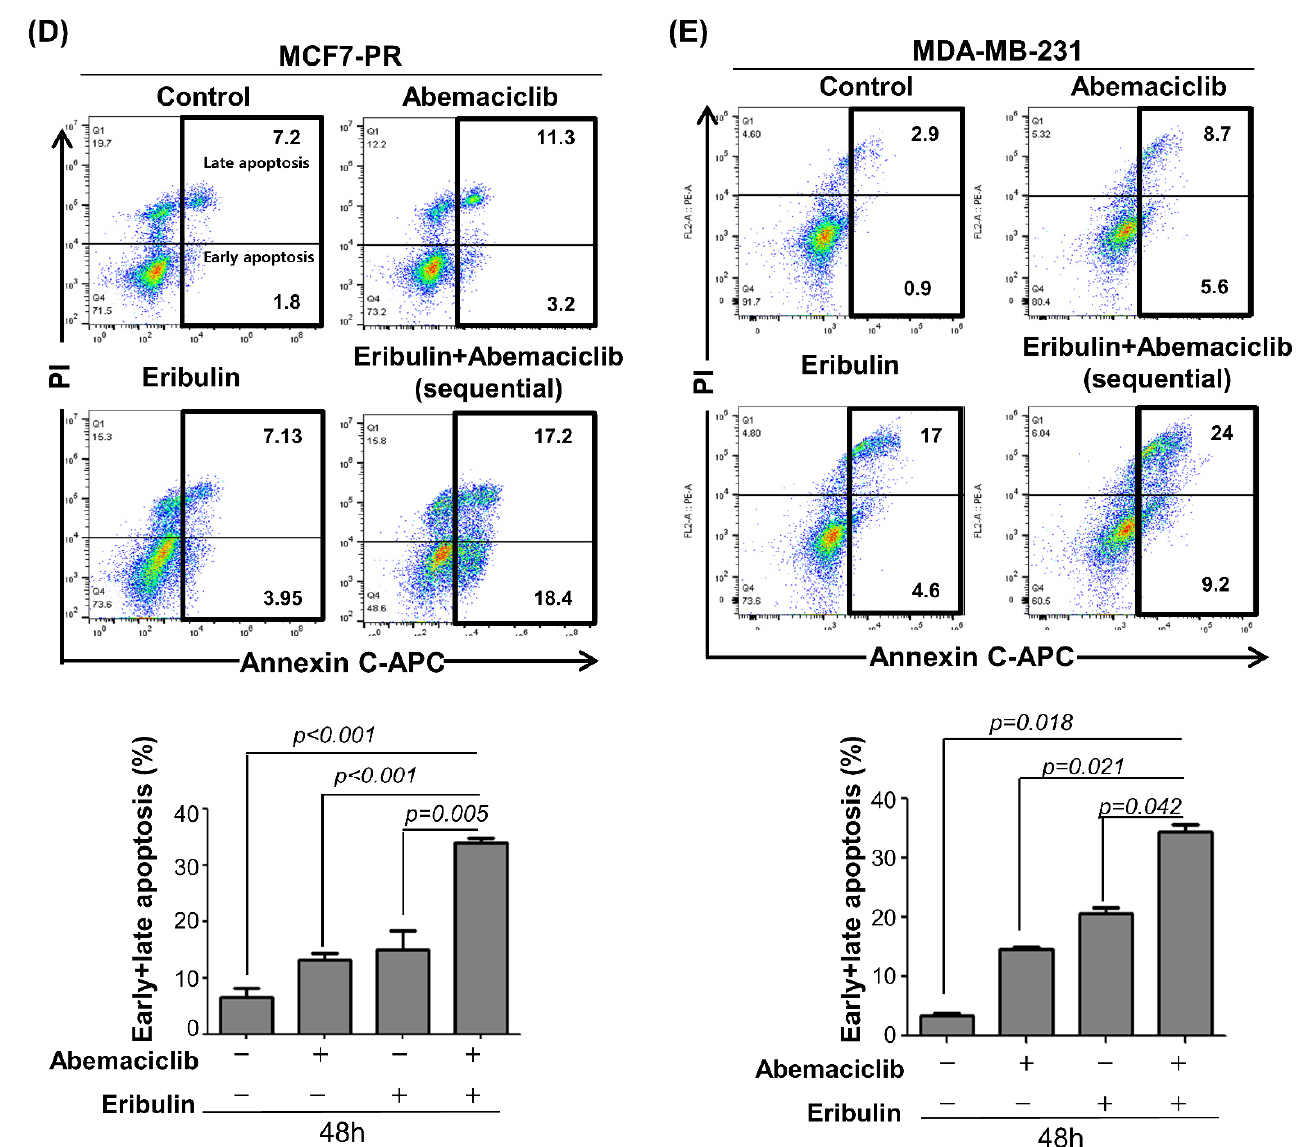
Figure 3. Eribulin and abemaciclib treatment causes mitotic arrest followed by cell death. ( A ) MCF7-PR and MDA-MB- 231 cells were treated with IC25 concentration of eribulin or abemaciclib and their combination for 48 h. Eribulin and abemaciclib combinations treatment was sequentially performed without a time gap between the drugs. Cell cycle distri- bution was analyzed by flow cytometry. ( B ) The histogram represents the distribution of cells in the G0/G1, S, and G2/M phases, and the bar graph indicates the percentage of cells in the G0/G1, S, and G2/M phases of the cell cycle. ( C ) MCF7- PR cells were treated with IC25 concentration of eribulin or abemaciclib and their combination for 48 h. Both drugs were given simultaneously for the combination treatment group. ( D , E ) MCF7-PR and MDA-MB-231 cells were treated with IC25 concentration of eribulin or abemaciclib and their combination for 48 h. Eribulin and abemaciclib combination treat- ment were performed sequentially, without a time gap between the drugs. Cells were stained with annexin V-APC/PI, and the apoptosis was measured by flow cytometry. The data shown are representative of three independent experiments. p -values were calculated by Student’s t-test. Histograms are drawn from the summation of the numbers in the box drawn. Data are presented as mean ± standard deviation from three independent